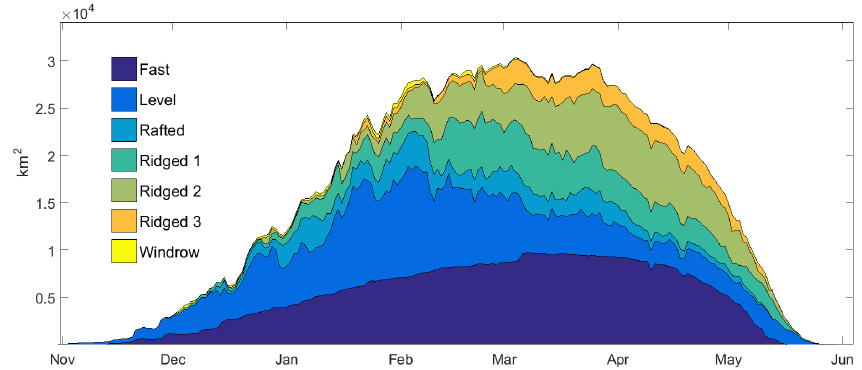
Figure 4. The seasonal development of charted ice area as divided into ice types. Season day averages over 14 seasons, including open